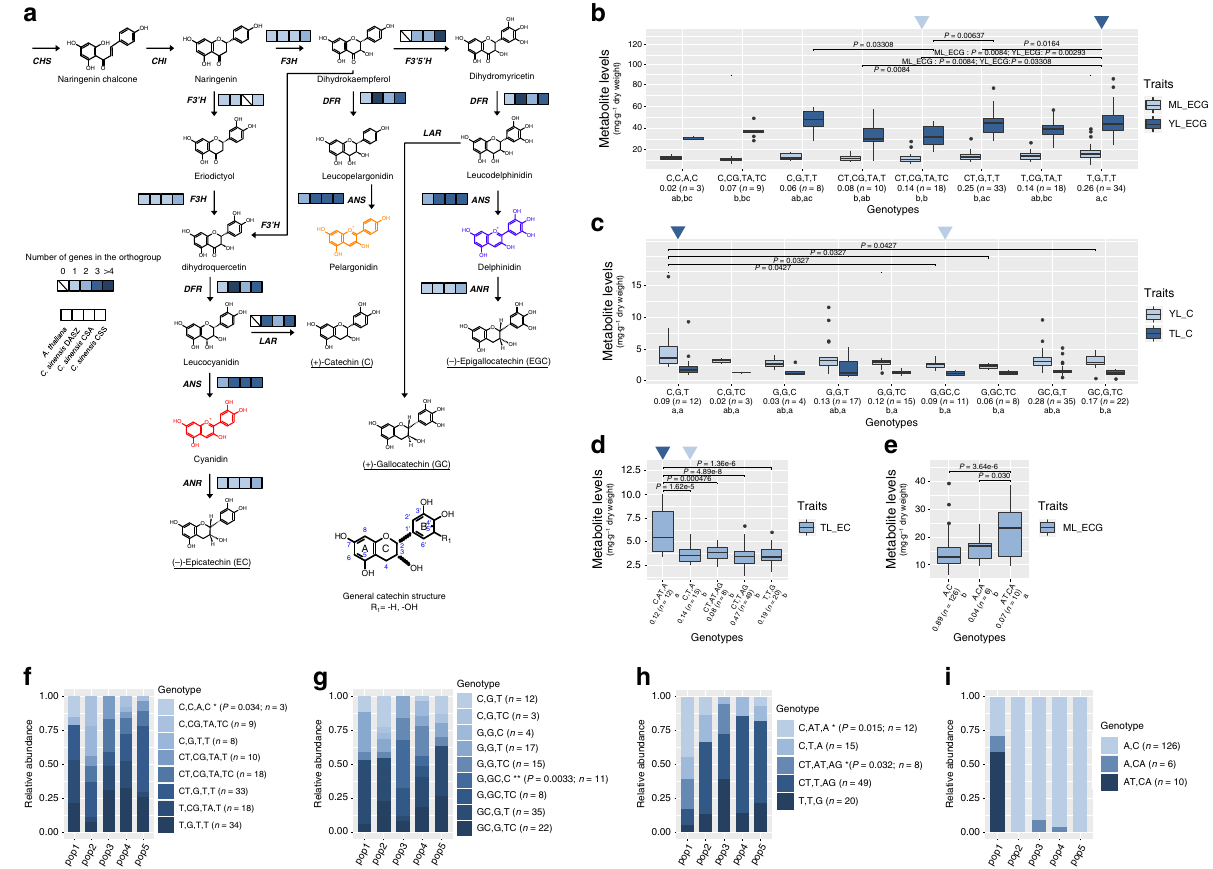
Fig. 4 Catechin biosynthesis pathway and identi fi cation of favorable genetic variants of candidate genes. a General scheme for the biosynthesis of non- galloylated catechins in Camellia species. The main catechins accumulating in Camellia species are underlined. Catechins are essentially the products of reduction, catalysed by ANR or LAR, of either leuco- or anthocyanidins. For the main metabolic steps, the number of genes contained in the respective orthogroup from A. thaliana , C. sinensis (DASZ), C. sinensis (CSA), and C. sinensis (CSS) is indicated by the colored boxes. Gene names are abbreviated in black. CHS chalcone synthase, CHI chalcone isomerase, F3H fl avanone 3-hydroxylase, F3 ′ 5 ′ H fl avonoid 3 ′ 5 ′ -hydroxylase, F3 ′ H fl avonoid 3 ′ -hydroxylase, DFR dihydro fl avonol 4-reductase, ANS anthocyanidin synthase, LAR leucoanthocyanidin reductase, ANR anthocyanidin reductase. b – e Boxplots of the genotype (each SNP site is separated by comma, and N/N indicates heterozygous SNPs) analysis using non-synonymous SNPs in the candidate genes for W12g026224 ( CsF3 ′ 5 ′ H ), W08g018649 ( CsANR ), W12g025045 ( CsMYB5 ), and W13g026373 ( CsTT2 ), respectively. The middle line of the box represents the median, the fi rst (25%) and third (75%) quartiles are indicated by the lower and upper boundaries and the whiskers show the minimum and maximum values, excluding outliers. The black points outside the whiskers indicate the outliers. The fi rst line of xlab shows the genotypes and the second line indicates the frequency of the corresponding genotypes in tea population. The last line shows the signi fi cant levels obtained by Tukey ’ s test (adjusted P < 0.05; two sided). Dark blue and light blue triangles in ( b – d ) indicate the selected genotypes for further functional validation. f – i Stack barplots of genotypes of CsF3 ′ 5 ′ H , CsANR, CsMYB5 , and CsTT2 distribution among tea subpopulations, respectively. Each color in barplot indicates one genotype. The asterisks after the genotypes represent the signi fi cant levels of fi sher exact test (* P < 0.05; ** P < 0.01; Fisher exact test; two sided). Source data underlying ( b – i ) are provided as a Source Data fi respectively (adjusted P = 9.18156 × 10 − 5 for CSS and 0.00111415 for DASZ), while Yunkang 10 had a loss of 17 UGT73 orthologs, adjusted P = 3.1353 × 10 − 13 ; Supplementary Data 11, 13).